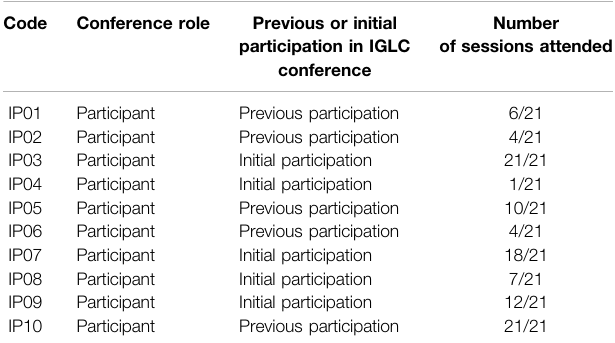
TABLE 1 | Information on participants in semi-structured interviews (Note: Sessions lasted ∼ 60 min